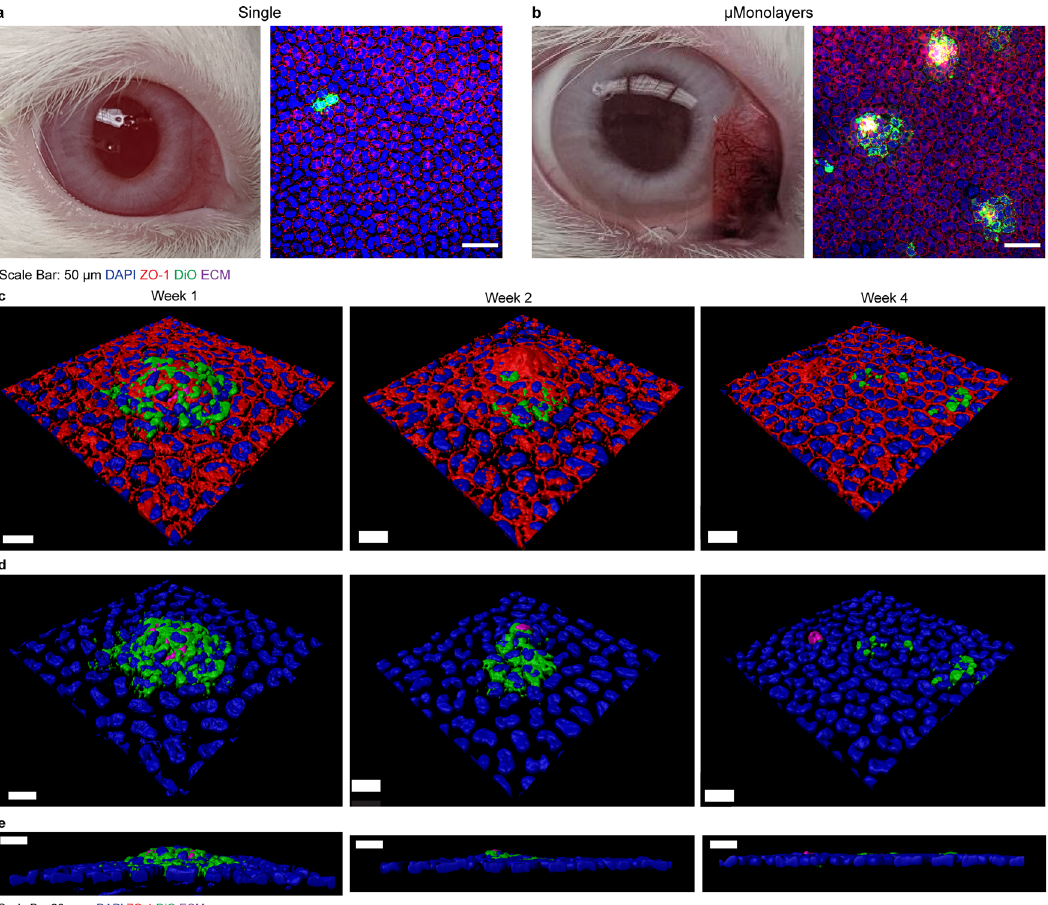
Fig. 6 Shrink-wrapped μ Monolayers integrate into the existing healthy rabbit CE. a Rabbit corneas injected with single cells remained clear at 1 week post injection. However, very few DiO-labeled single cells were observed integrated into the rabbit CE. b The rabbit cornea injected with μ Monolayers also remained clear 1-week post injection and numerous clusters of μ Monolayers were observed in each cornea with the continuous ZO-1 at the borders between DiO-labeled cells and native rabbit CE cells. c Confocal microscopy images showing the integrated DiO-labeled shrink-wrapped μ Monolayers at 1, 2-, and 4 weeks post injection. Nuclei = blue, DiO-labeled cells (green), ZO-1 (red), ECM nanoscaffold (purple). d The same images from c with the ZO-1 removed to highlight the nuclei of both the healthy rabbit endothelium and injected cells (blue), DiO-labeled injected rabbit cells (green), and ECM nanoscaffold (purple) from the shrink-wrapping process at 1, 2-, and 4 weeks post injection. e The orthogonal views of the confocal images shown in d showing the integration of the shrink-wrapped μ Monolayers into the healthy rabbit endothelium over the 4-week period post injection. Scale bars in a and b are 50 μ m, and in c – e are 20 μ